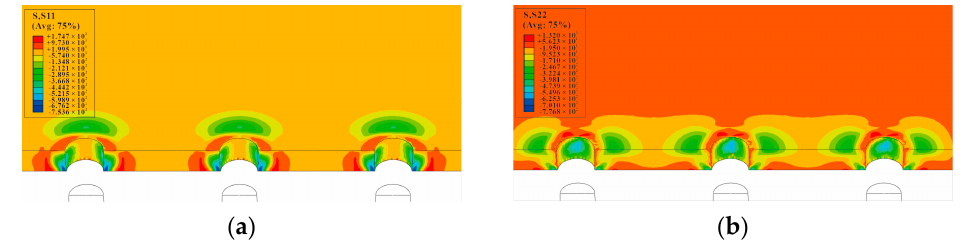
Figure 16. SSCE of the sample with three times the hole diameter as the hole spacing. The circumferential and radial residual stress nephogram at the hole edge after CE: ( a ) S11/circumferential stress distribution nephogram (MPa); ( b ) S22/radial stress distribution nephogram (MPa).